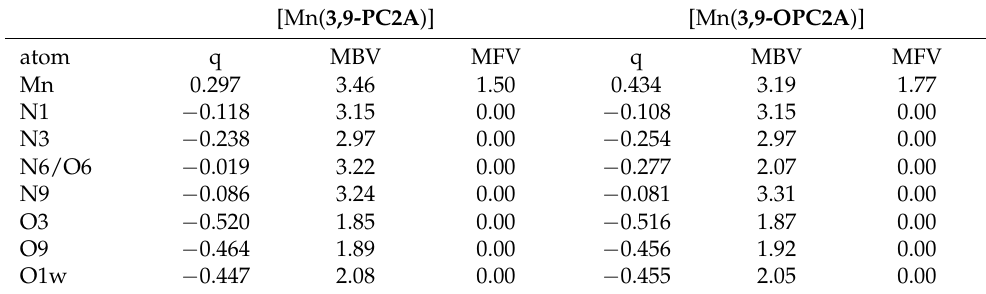
Table 8. Mulliken partial atomic charges (q, in a.u.), Mayer bonding valence (MBV, in a.u.), and Mayer free valence (MFV, in a.u.) of relevant atoms within the complexes [Mn( 3,9-PC2A )] and [Mn( 3,9-OPC2A )]. [Mn( 3,9-PC2A )] [Mn( 3,9-OPC2A )] atom q MBV MFV